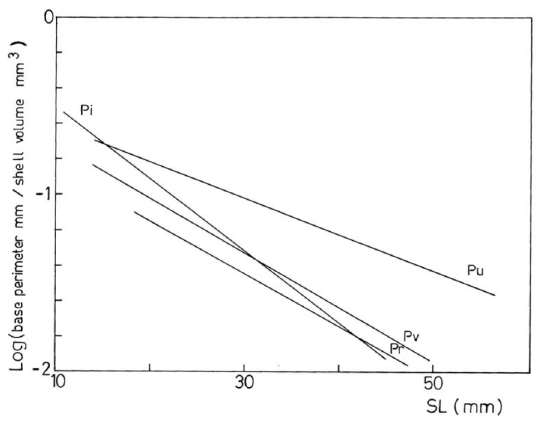
Fig. 6. Plots of the ratio between the base perimeter and shell volume, against shell length (Pi = P. intermedia , Pr = P. rustica , Pu = P. ulyssiponensis , Pv = P. vulgata ).